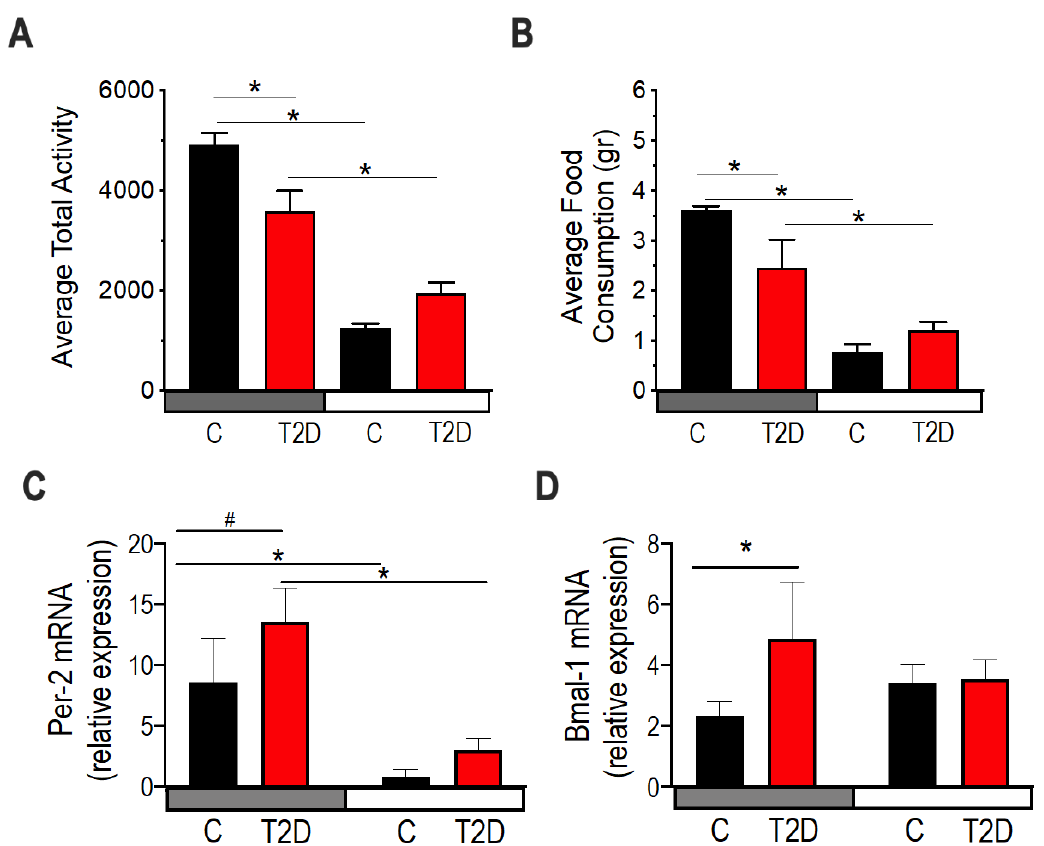
Figure 6. Diurnal activity, food consumption, and circadian gene expression in type 2 diabetic mice (T2D). 10-month-old db/db (red) and aged-matched controls, db/m (black). ( A , B ) All measurements were performed after a 48-h acclimation period followed by 48-h of data collection every 10 min. ( A ) Mean activity over the night period (19:00–07:00) and the day period (07:00–19:00). n = 8 per group. Two-way ANOVA. (*) indicate statistical significance at post-hoc multiple comparison test. ( B ) Food consumption during the dark period and the day. n = 8 per group. Two-way ANOVA. Asterisks indicate statistical significance at post-hoc multiple comparison test. ( C ) mRNA expression of Per -2 in colonic tissue ( n = 3). Two-way ANOVA. (*) indicate statistical difference p < 0.05, and (#) p < 0.01 in post-hoc comparisons. ( D ) mRNA expression of Bmal-1 in colonic tissue. ( n = 3). Two-way ANOVA. (*) indicate statistical difference p < 0.05, and (#) p < 0.01 in post-hoc comparisons.